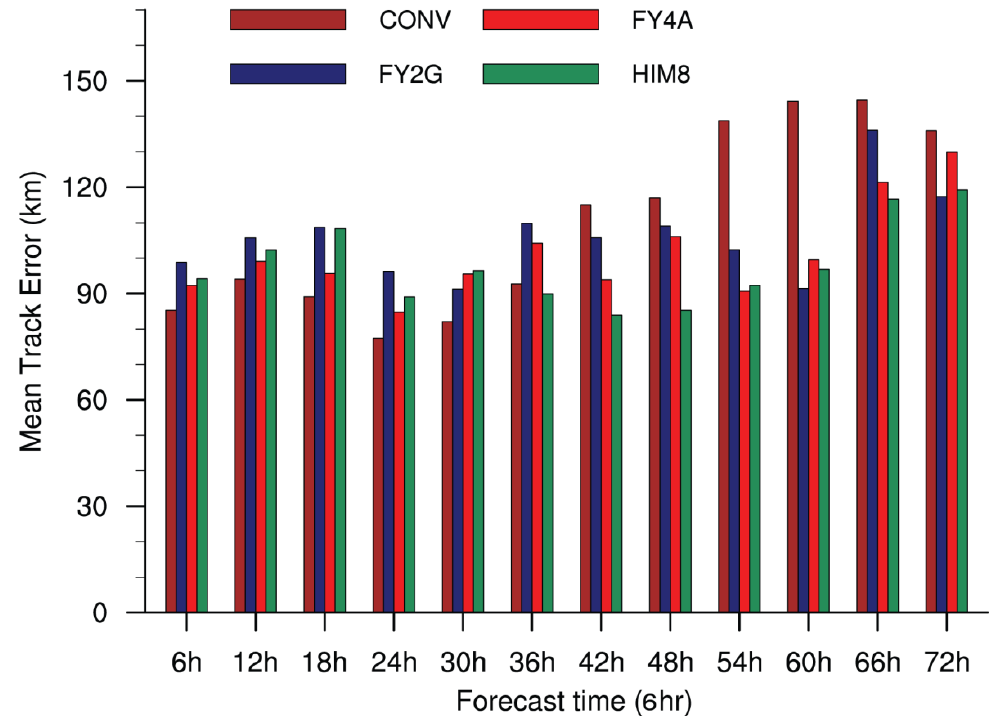
Figure 15. The comparison for every 6 h integration time to 72 h for the average track forecast difference from the Joint Typhoon Warning Centre (JTWC) observed best-track data from all the experiments of TC PABUK.